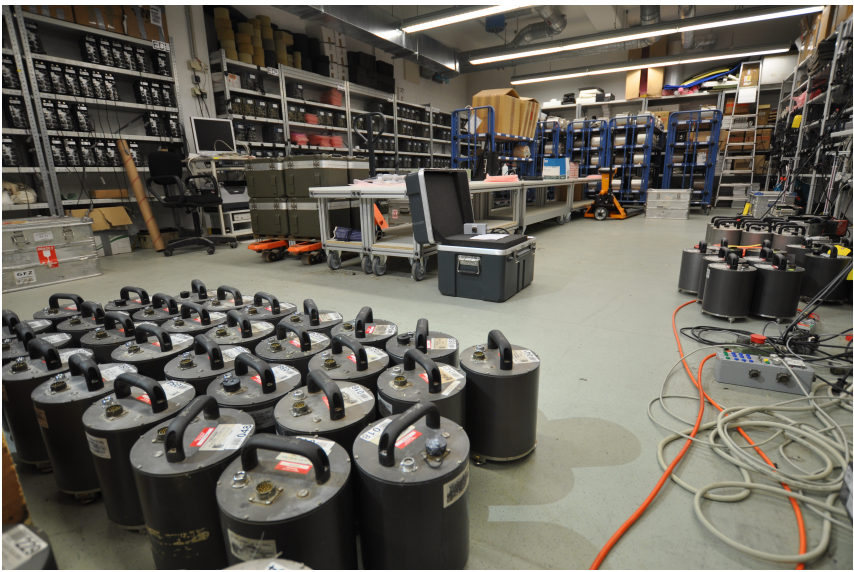
Figure 1: Geophysical field instruments in the storage in